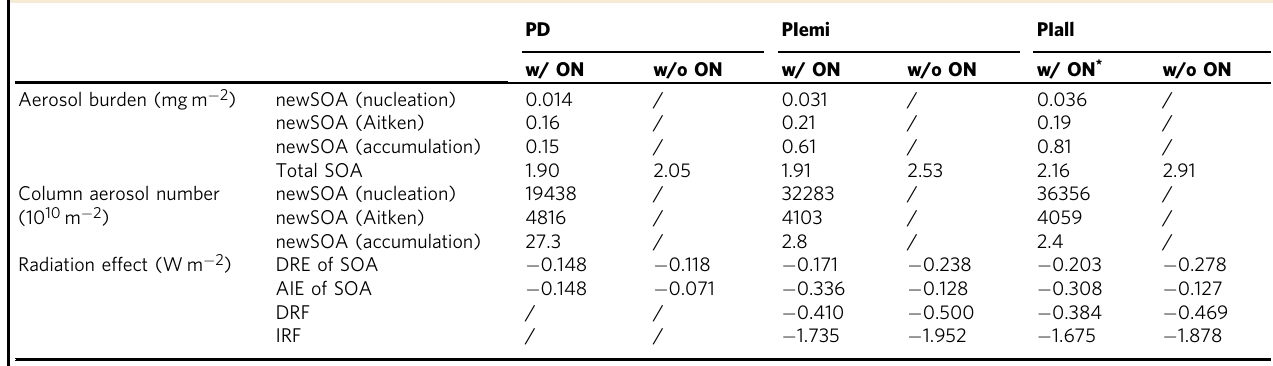
Table 1 Summary of the global average SOA burden, number and radiative effects in PD, PIemi and PIall schemes with and without organic nucleation